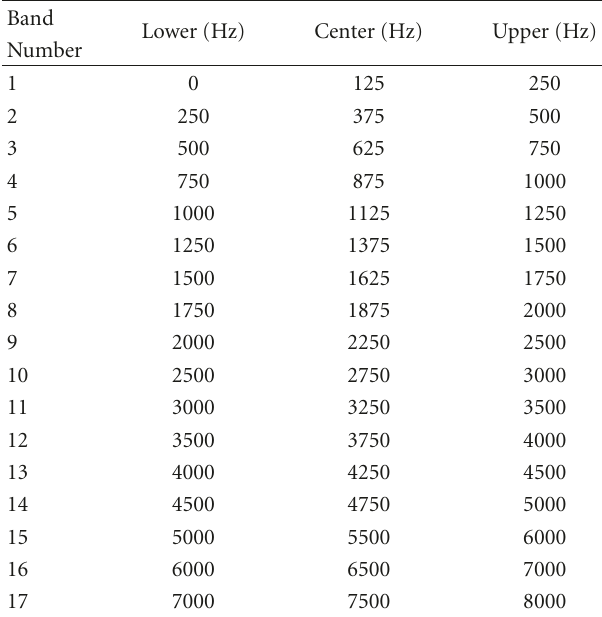
Table 1: Frequency limits used for perceptual wavelet packet integration